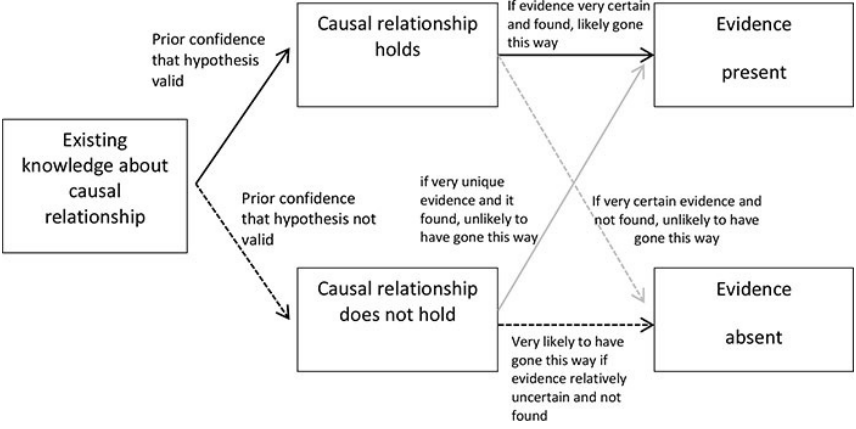
Fig. 1 Causality test